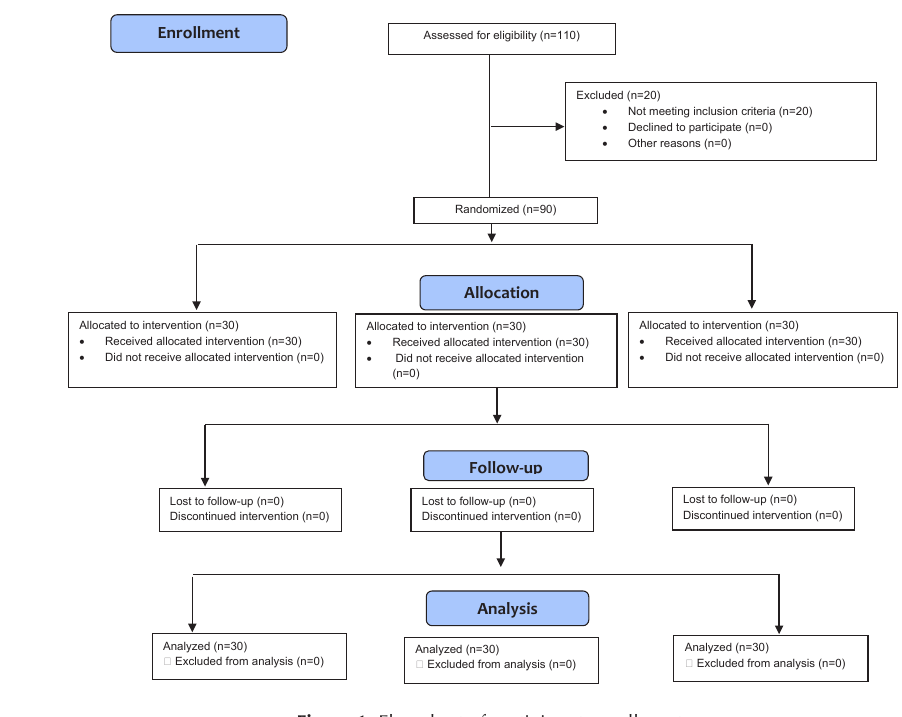
Figure 1. Flowchart of participant enrollment.